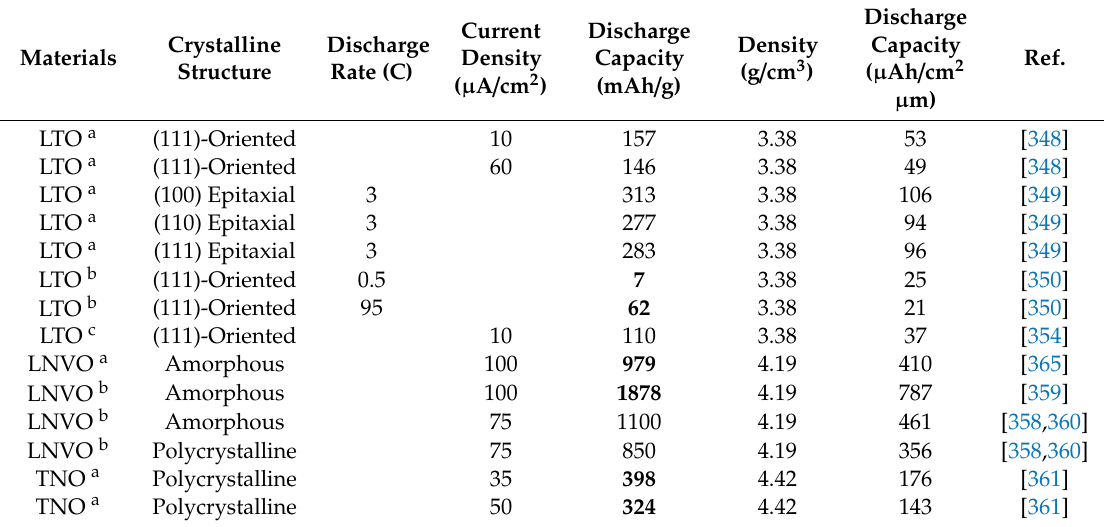
Table 6. Comparison of the discharge capacity among di ff erent anode